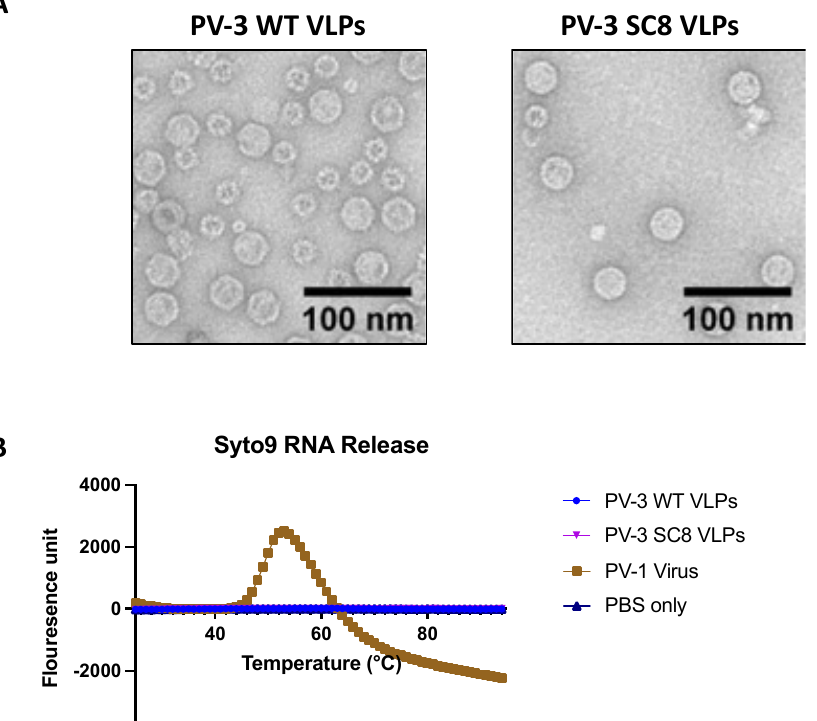
Figure 4. Negative stain transmission electron microscopy of yeast-derived VLPs and PaSTRy. ( A ) : Representative micrographs from preparations of PV-3 wt and PV-3 SC8 VLPs, stained with uranyl acetate. Scale bar shows 100 nm. ( B ): Particle Stability Thermal Release assay (PaSTRy) equal amounts of either VLP or infectious virus samples were assessed for RNA release over an increasing temperature gradient. PBS was used as a negative control and fluorescence is represented in arbitrary units. The figure is a representative example of three separate experiments.